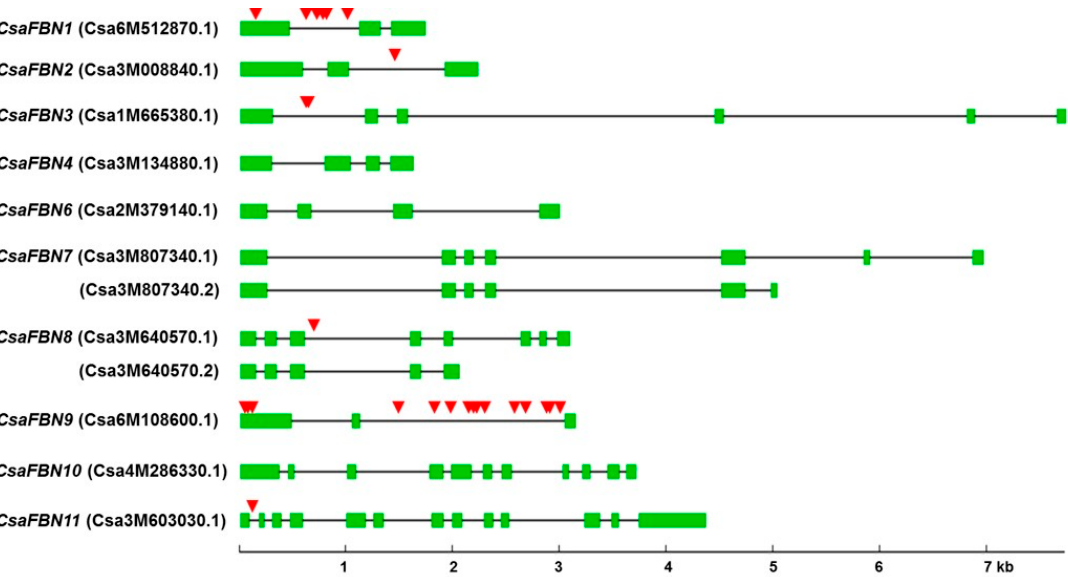
Figure 2. Gene structures and polymorphism of FBN genes in cucumber. Gene structure information of 10 cucumber FBN genes were retrieved from Cucurbit Genomics Database. Exons and introns are indicated by green boxes and black intervening lines, respectively. Two alternative spliced forms, Csa3M640570.2 and Csa3M807340.2 , were also included. Red triangles indicate polymorphic sites found between var. Chinese long and Gy14 (Table S1).